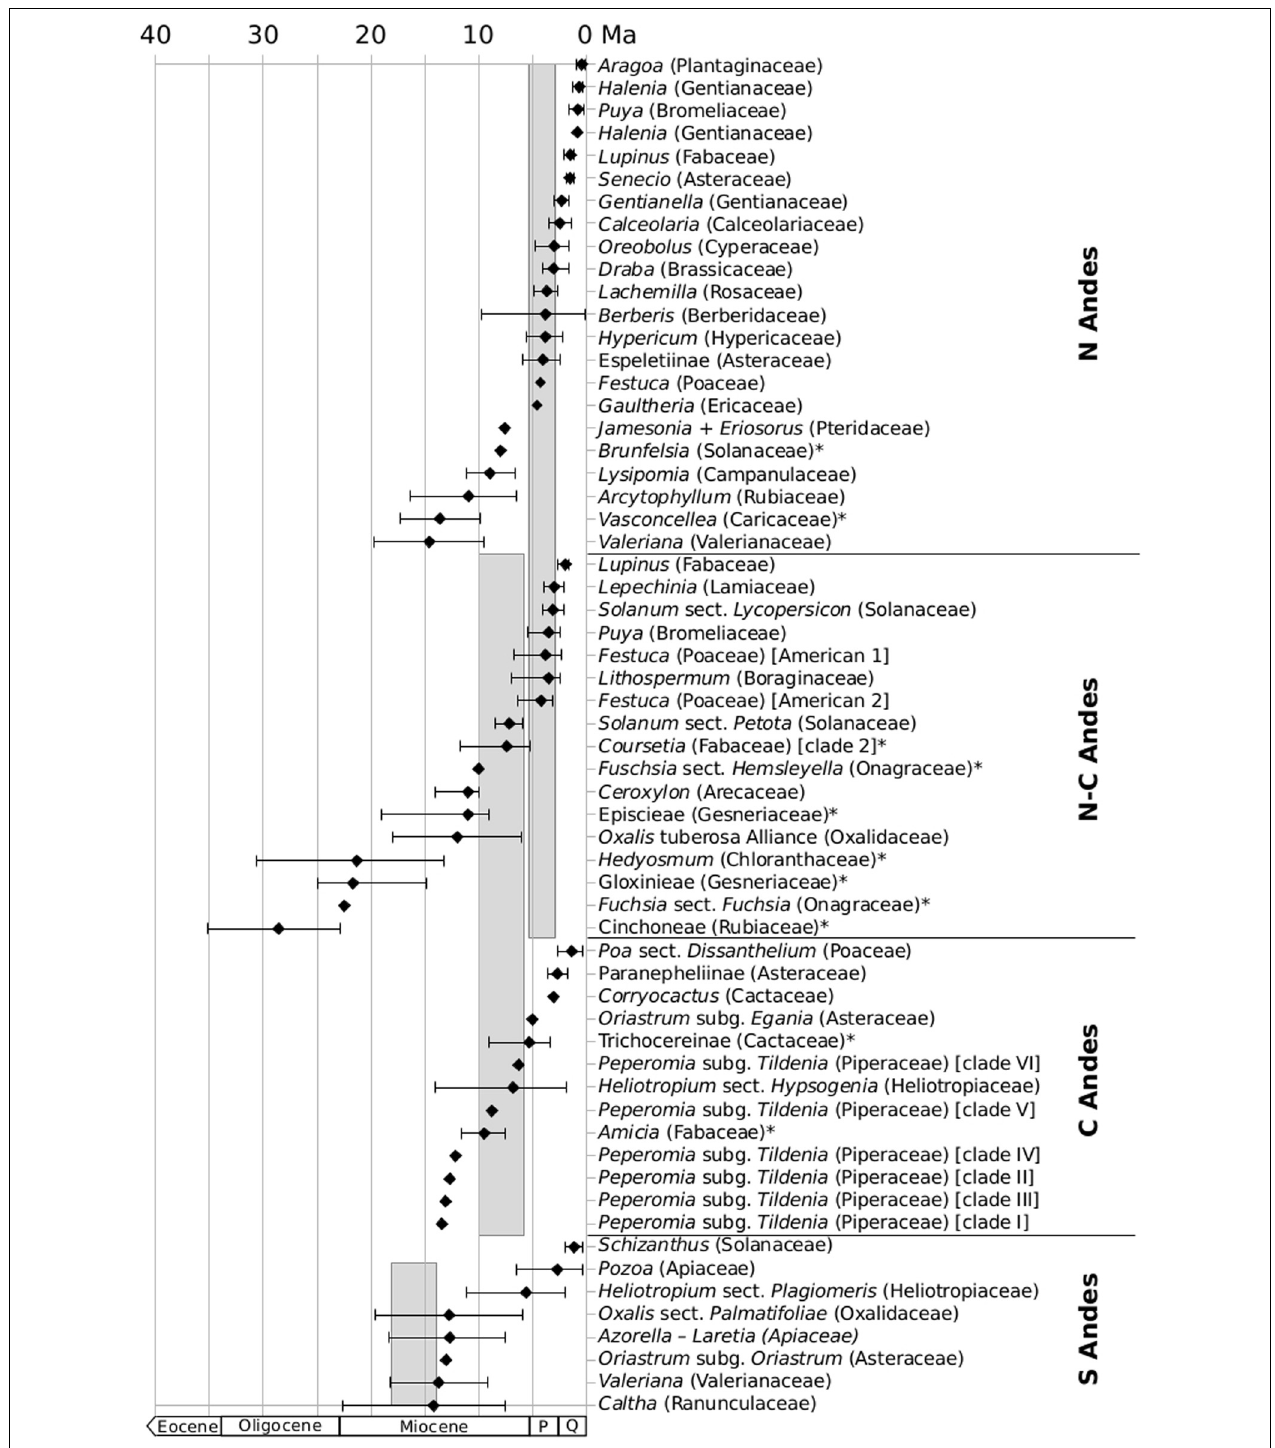
FIGURE 2 | Divergence times for high- and mid-elevation Andean groups that may have diversified in response to the Andean uplift. Mid-elevation groups are signalised by asterisk. Groups are sorted by their geographical distribution in the Northern, Central, and Southern Andes and putative age ranges for the rapid phases of